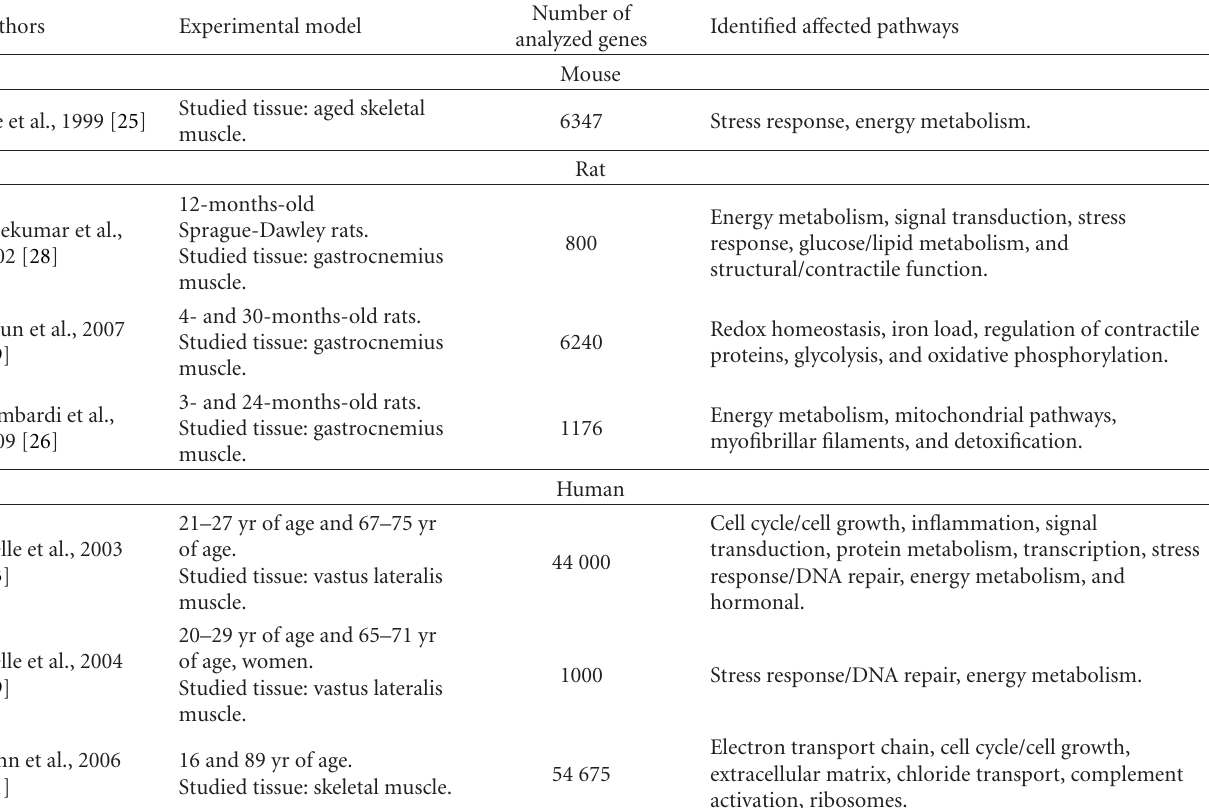
Table 1: Summary of the models used and of the major findings obtained by applying microarray technologies to the study of ageing skeletal